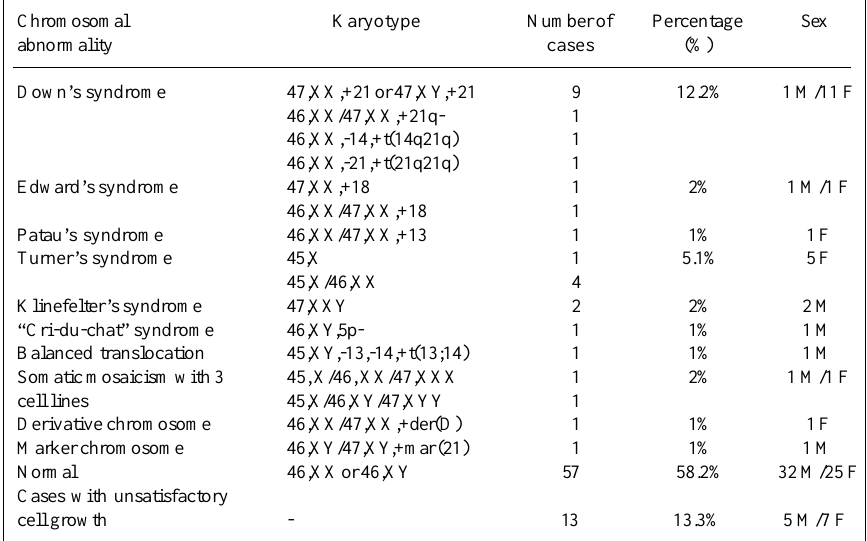
Table I - Cytogenetic results for 98 mental retardation patients from the Hospital Universitário Pedro Ernesto and other adjacent hospitals, showing the frequency of abnormalities and the numbers of each sex